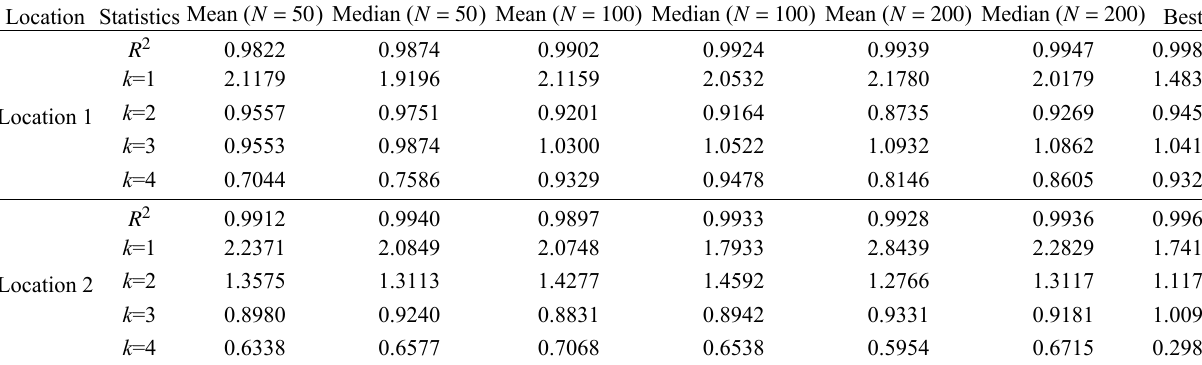
∆ t = 2 Table 4 Reproduction number (refer to Eq. (4)), week, PSO.